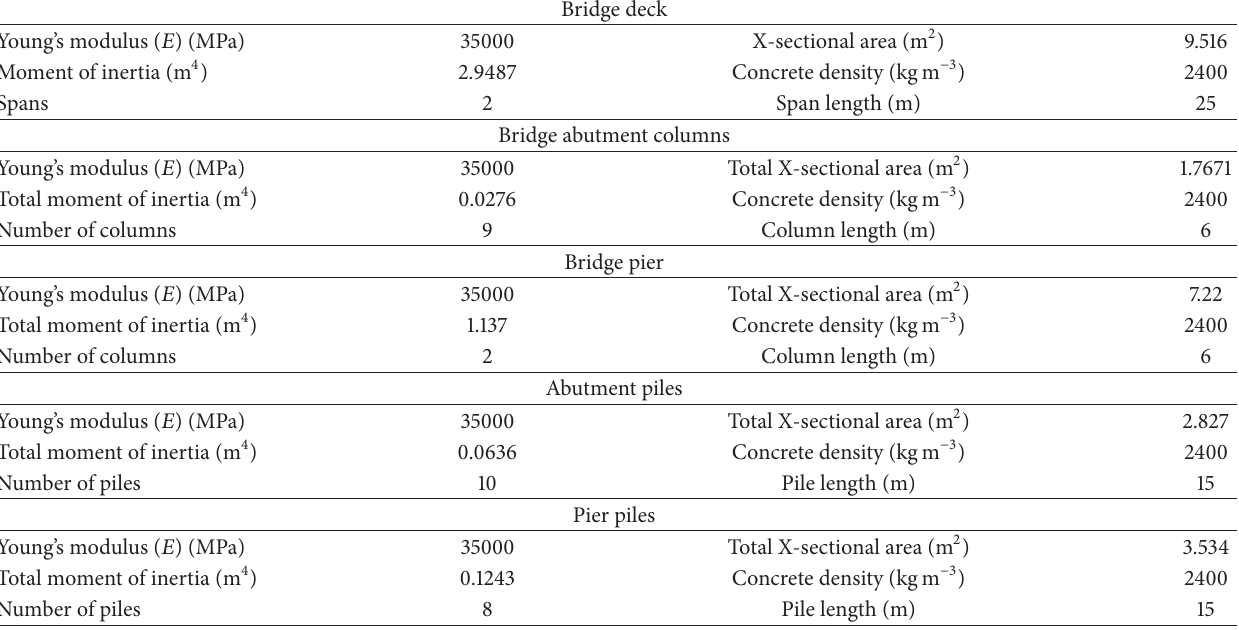
Table 2: Case study bridge